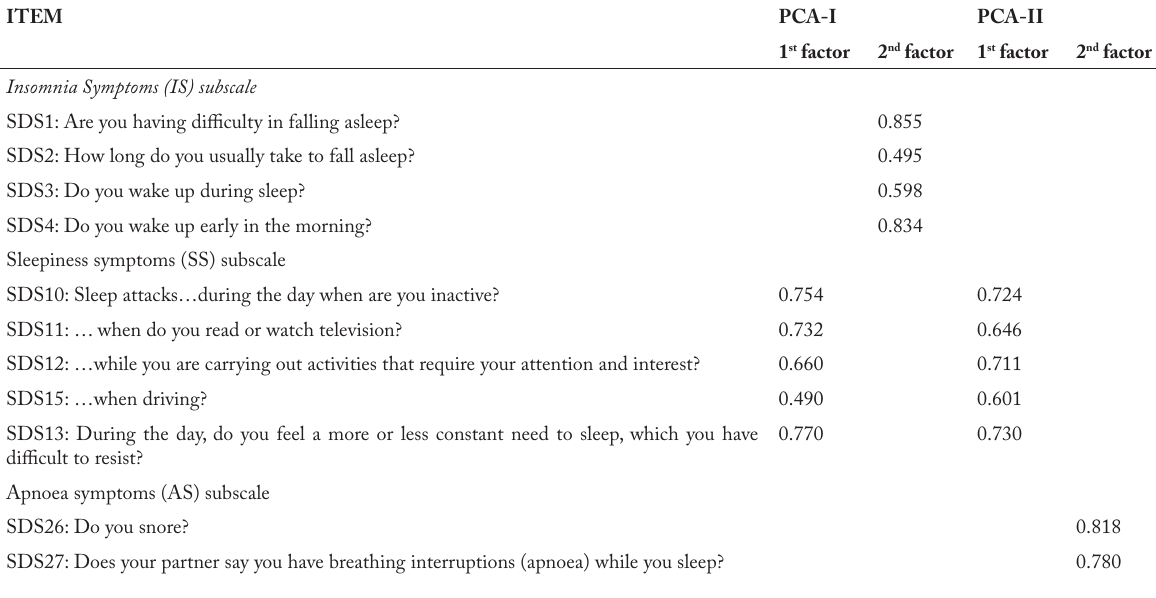
Table 2. Principal component analysis, with Varimax rotation and Kaiser normalization. Grouping in single factors of insomnia symptoms (IS), sleepiness symptoms (SS), and OSAS symptoms